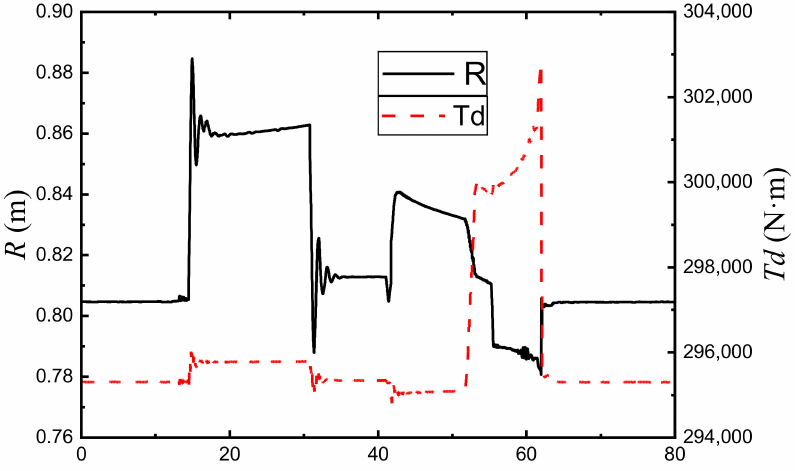
Figure 28. The variational trends of R and Td over